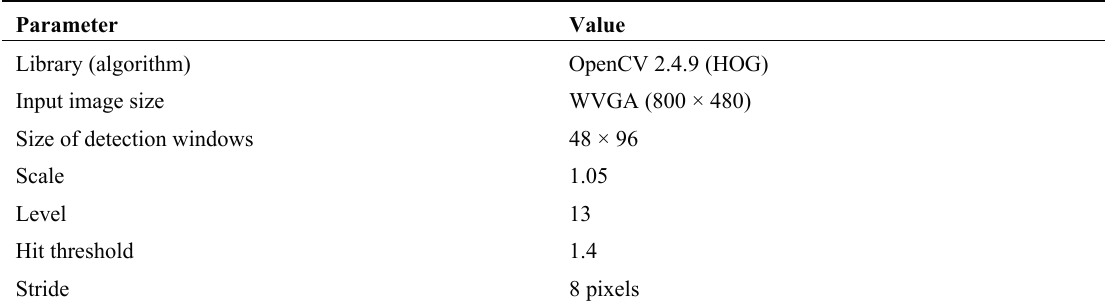
Table 2. Pedestrian recognition